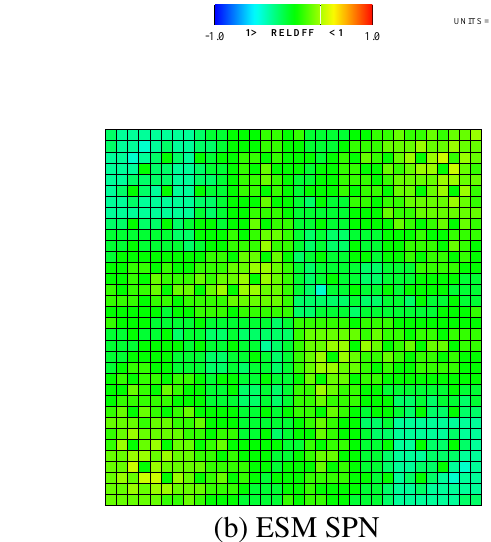
Figure 3: Relative pin power differences between PANTHER ESM diffusion and SPN-corrected solutions and a 22 group WIMS-CACTUS